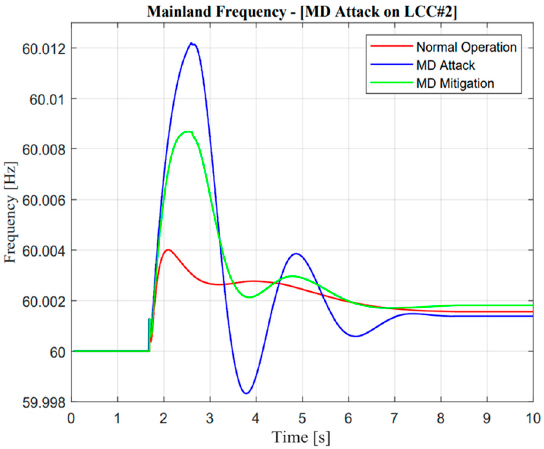
Figure 25. Mainland frequency in the missing data attack operation.